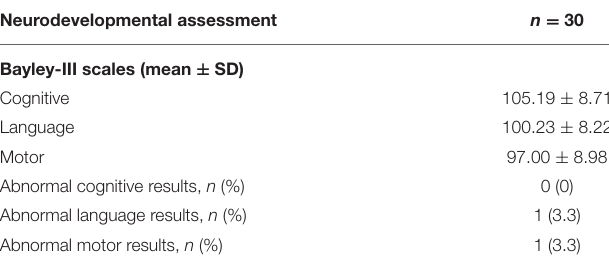
TABLE 3 | Logistic regression models of MRI results. Predictor